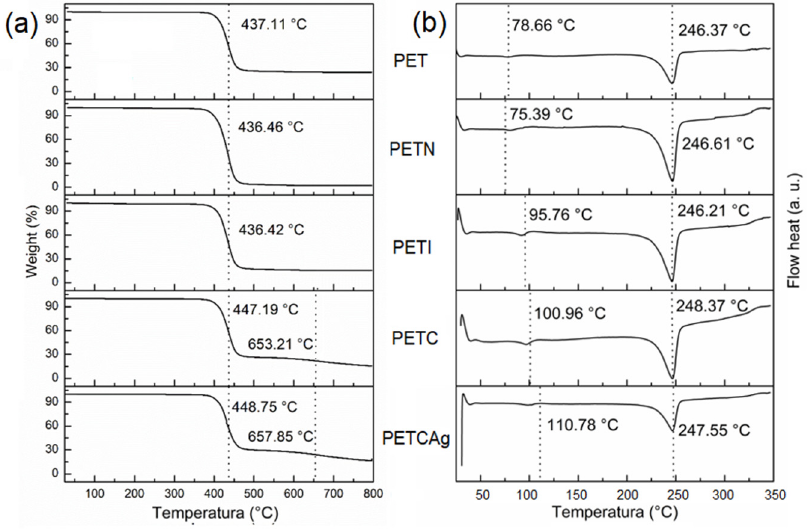
Figure 5. ( a ) TGA and ( b ) DSC studies under nitrogen flow on PET films obtained in the chitosan chain grafting process. Table 2. Decomposition temperatures of PET films obtained in the chitosan chain grafting process.